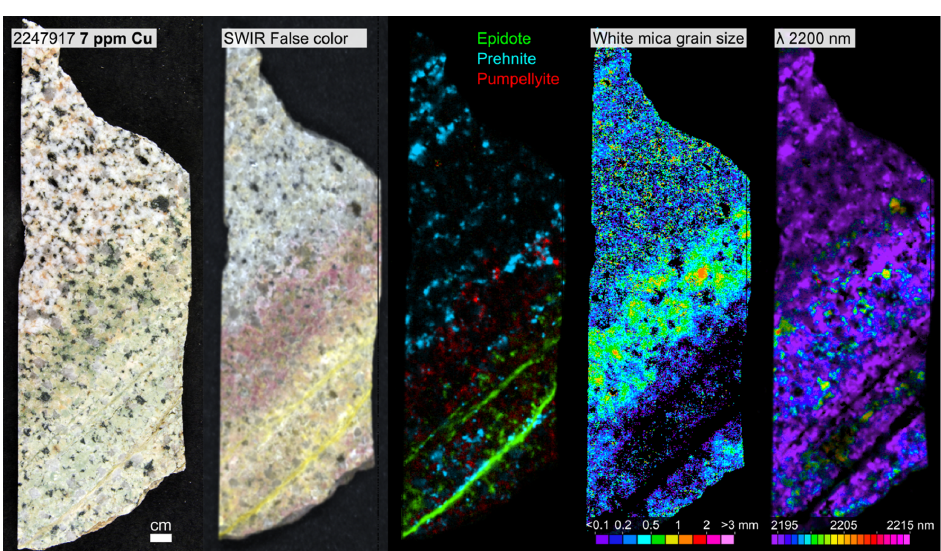
Minerals 2020 , 10 , 473 Figure A2. Sample 2232402, montmorillonite-rich matrix. Figure A2. Sample 2232402, montmorillonite-rich matrix.